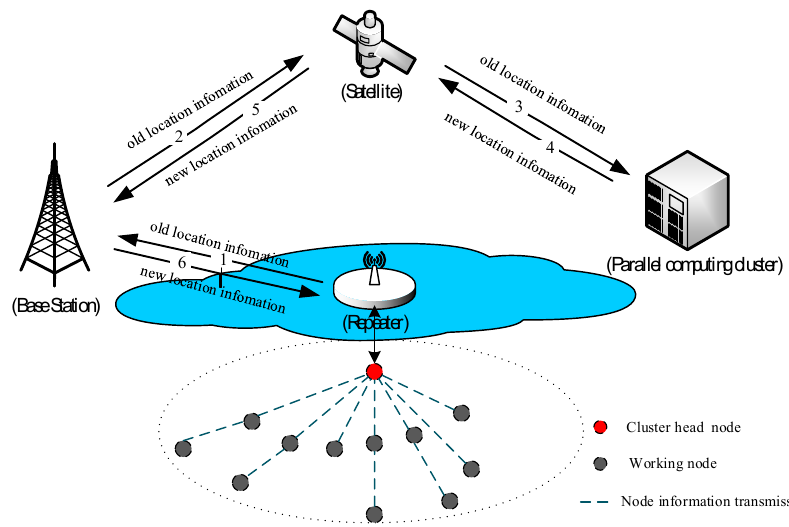
Figure 1. The process framework of location updates of an UWSN.